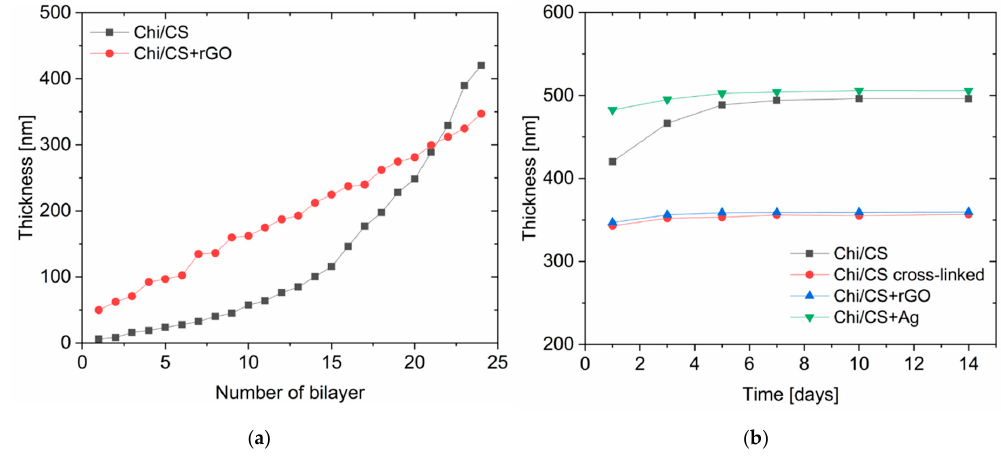
Figure 3. Build-up of Chi/CS multilayer film: ( a ) thickness; ( b ) swelling behavior in time.